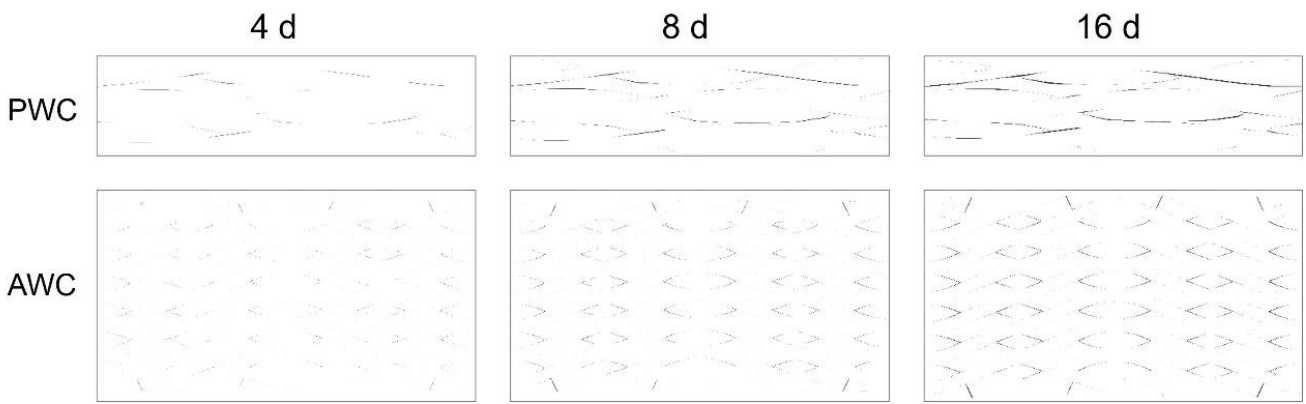
Figure 13. Evolution of interface cracks with the increase of ageing time.